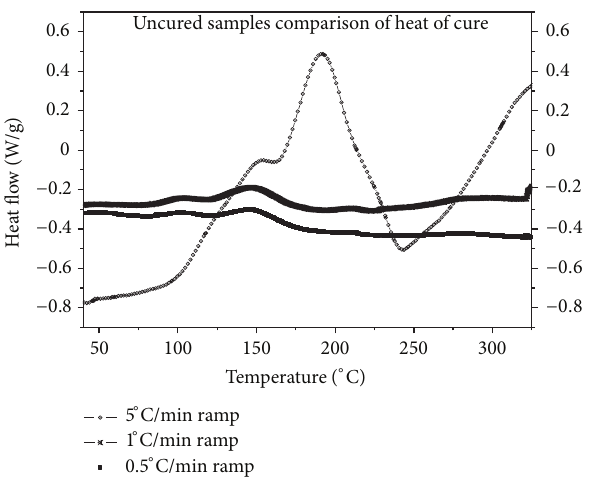
Figure 4: Uncured samples heat of cure comparison.